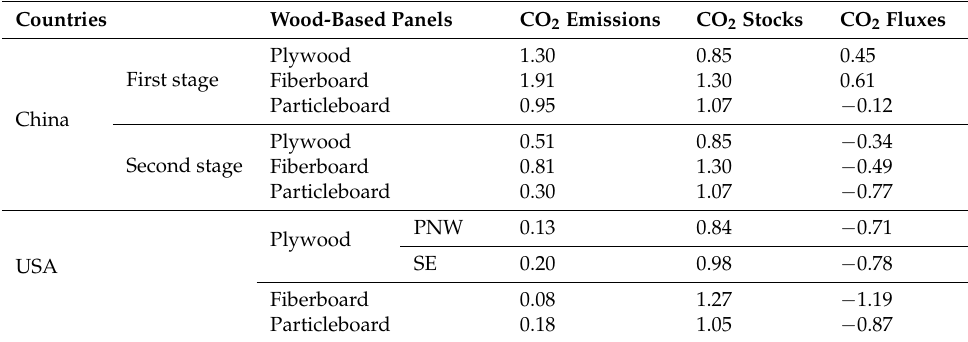
Table 4. CO 2 fluxes through the gate-to-gate life cycle of wood-based panels in China and the United States (t/m 3